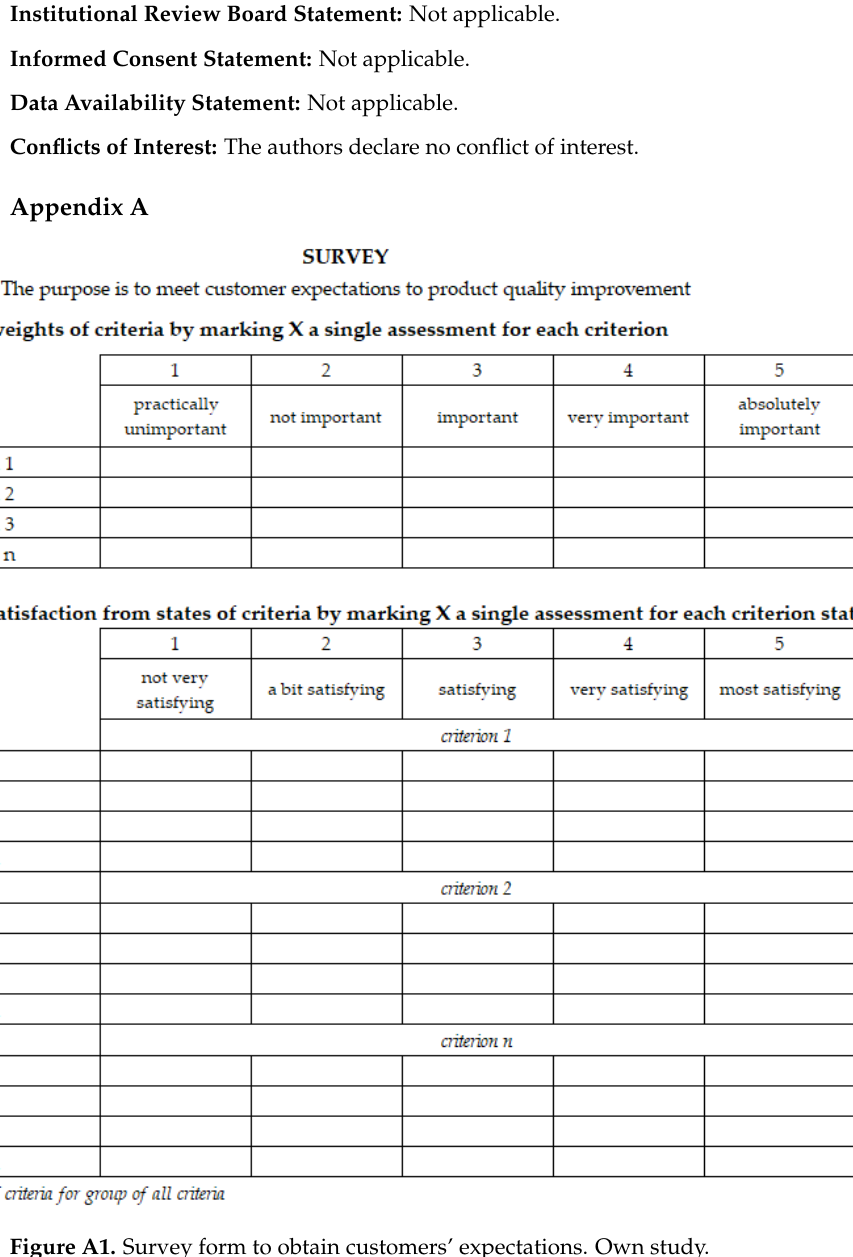
Figure A1. Survey form to obtain customers’ expectations. Own study.